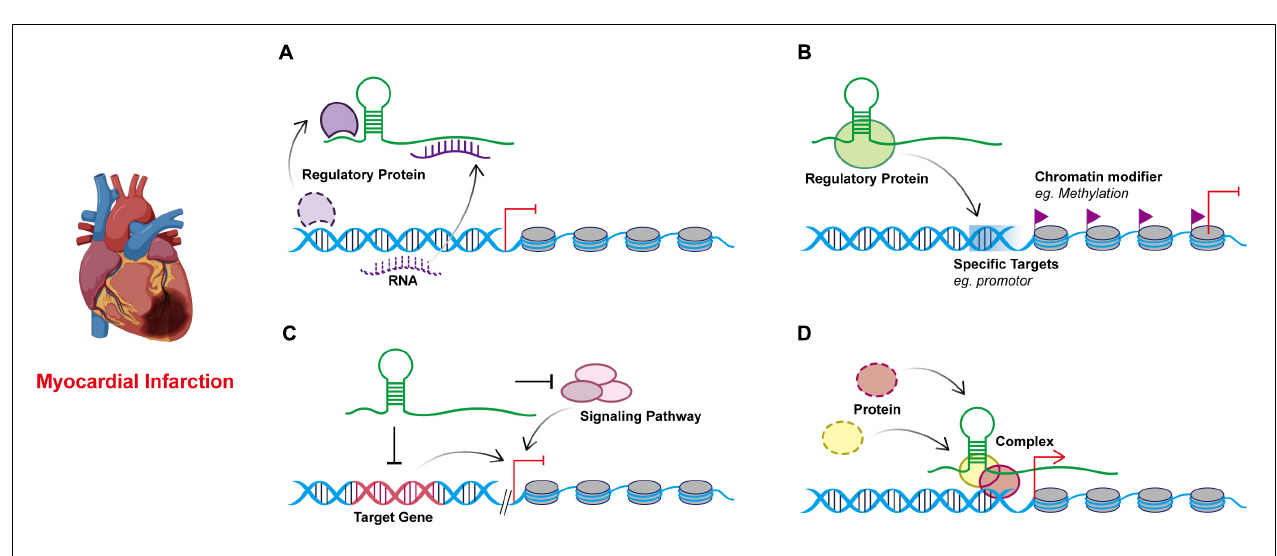
FIGURE 2 | Models of four known lncRNA molecular mechanisms of action in myocardial infarction. (A) Decoy. lncRNAs can act as sponges to interact with regulatory proteins or RNAs away from their targets. (B) Guide. lncRNAs can recruit and combine regulatory proteins or DNAs through molecular interactions and guiding the complexes to the specific targets. (C) Signal. lncRNAs respond to specific stimuli and participant in the regulation of gene expression by regulating signaling pathways through cis- or trans- way. (D) Scaffold. lncRNAs may serve as scaffolds to bring proteins together in biological